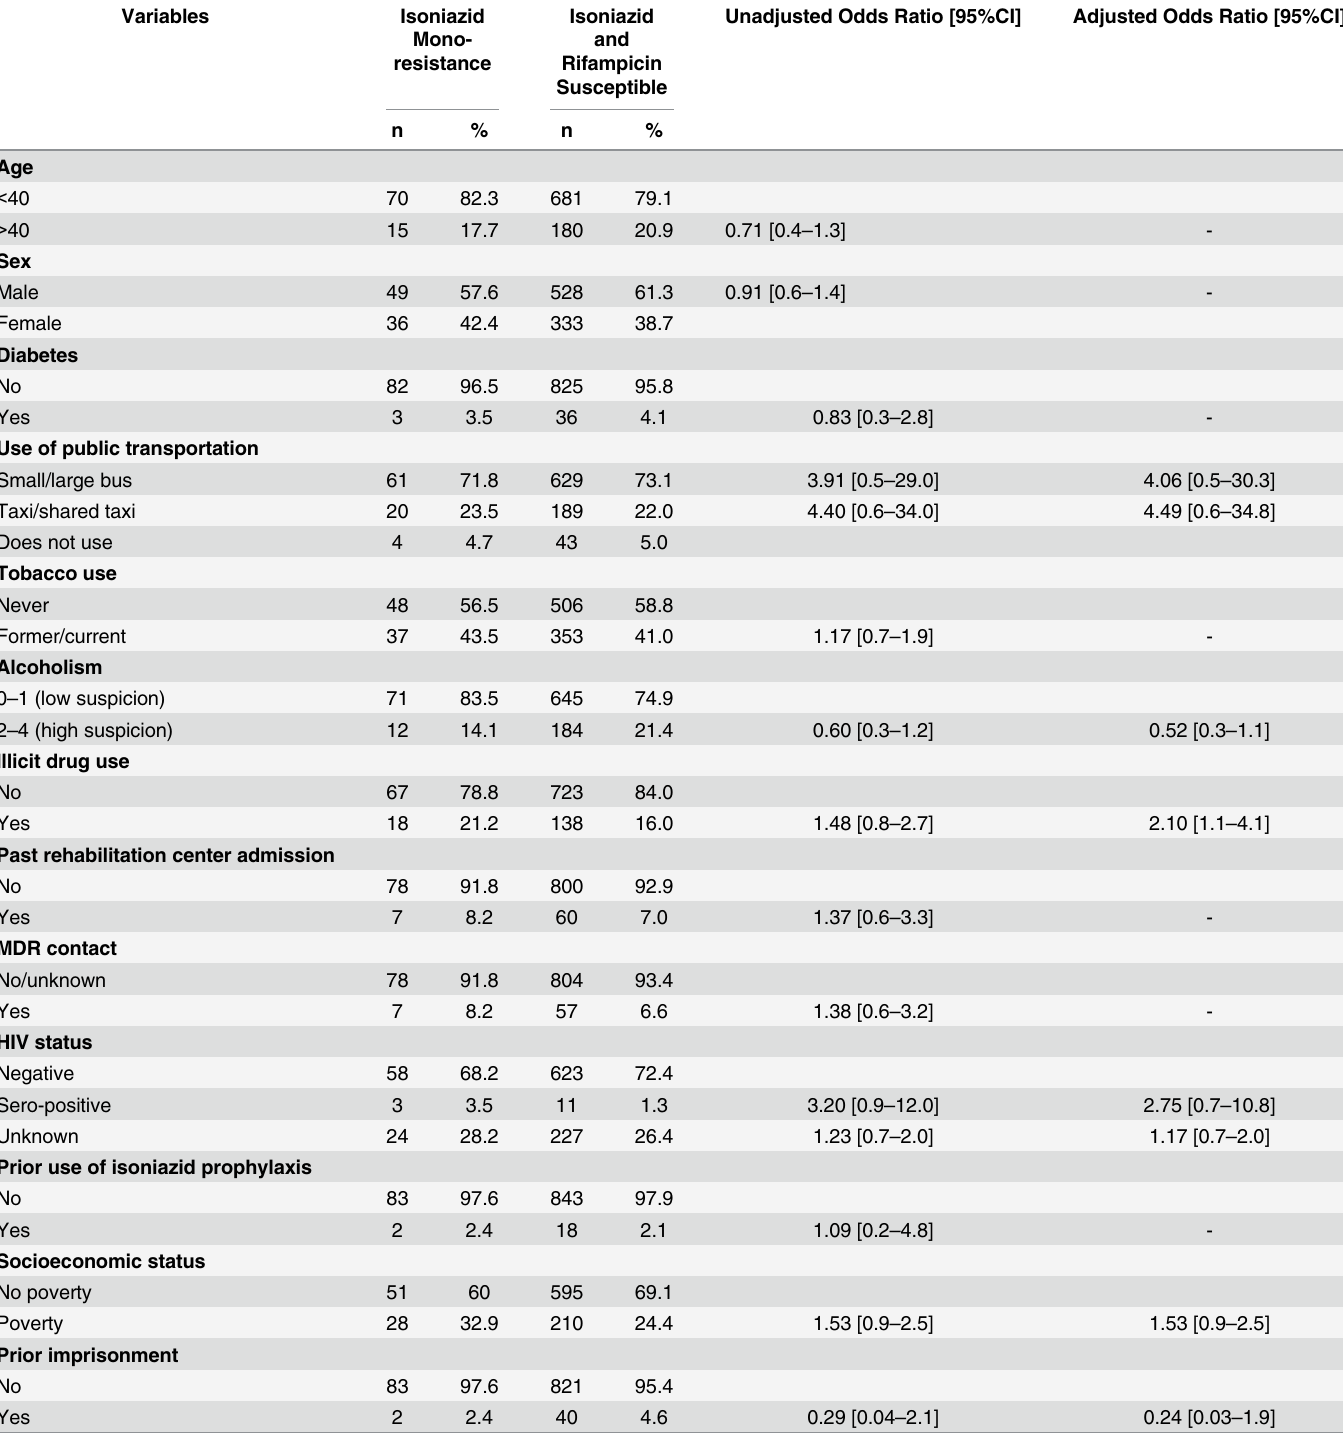
Table 2. Multivariate Analysis of Characteristics Associated with Isoniazid Mono-resistance.